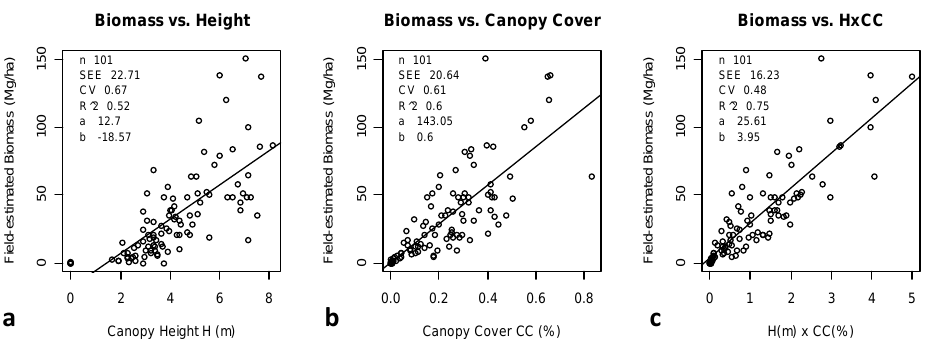
Fig. B1. Comparison of biomass calibration curves using height ( H ), canopy cover (CC), and H × CC as predictor variables. All 101 field plots from southern KNP across a range of dominant woody species were used to compare these three predictors. An additional 23 plots from northern KNP are dominated by C.mopane with significantly different morphology and stand densities than southern KNP, and thus received a separate calibration curve (Fig. 2c). Log-log and multivariate regressions using H , CC, H × CC were also tested, but none improved good- ness-of-fit ( R 2 ) or predictive performance (SEE, CV) compared to these linear fits. Table C1. Landscape models describing the relation of AGB to seven landscape factors at 0.5ha resolution. Area=the fraction of KNP cov- ered by each model type, µ =mean of n CAO AGB estimates at 0.5 ha/pixel, all other columns are model results. Polynomial terms up to 4th- order were tested for each factor to maximize goodness-of-fit while minimizing the number of terms and the standard error. Shale is a cons- tant because only a small area of homogenous vegetation structure ( A.harveyi thickets) was flown by CAO, insufficient in size for land- scape modeling.